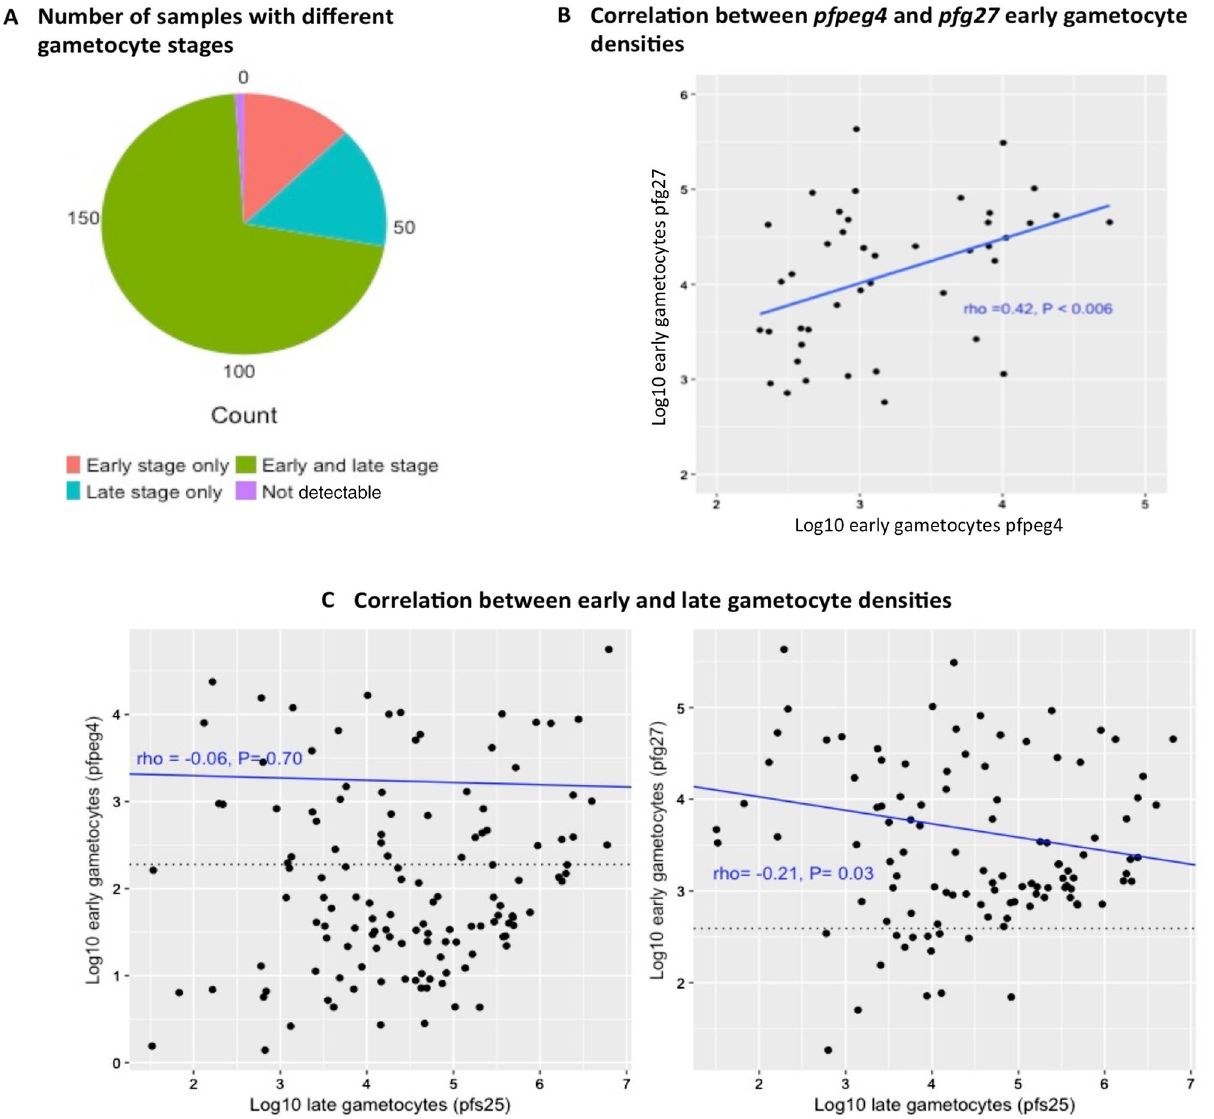
Figure 2. Early gametocytes in natural infections. ( A ) Number of samples with different gametocyte stages in field samples (n = 198). Early gametocyte detection is based on both pfpeg4 and pfg27 expression. ( B ) Correlation between log10 early gametocyte densities as detected by pfpeg4 and pfg27 . The figure shows correlations in samples where densities were above the LoQ. A figure demonstrating the correlation in all samples is given as supplementary Figure S4. ( C ) Correlation between log10 early ( pfpeg4 or pfg27 ) and late stage gametocytes/ ml of blood among samples with mixed stages. The figure shows that early stage gametocytes densities are independent, particularly for pfpeg4 , to the density of late stage gametocytes. The dotted line in both panels represents the LoQ. Correlation line, Spearman correlation coefficient (rho) and P value were calculated for points above the LoQ. Points below LoQ are robustly detectable however with higher uncertainty around the estimated